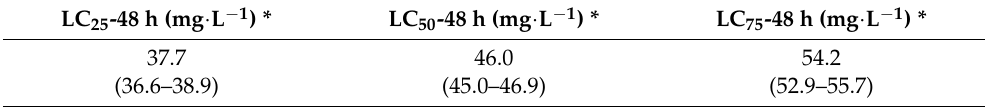
Figure 11. Illustration of the angles between rings for BRCHAL. Table 3. Larvicidal activity of BBP on A. aegypti larvae (L3) after 48